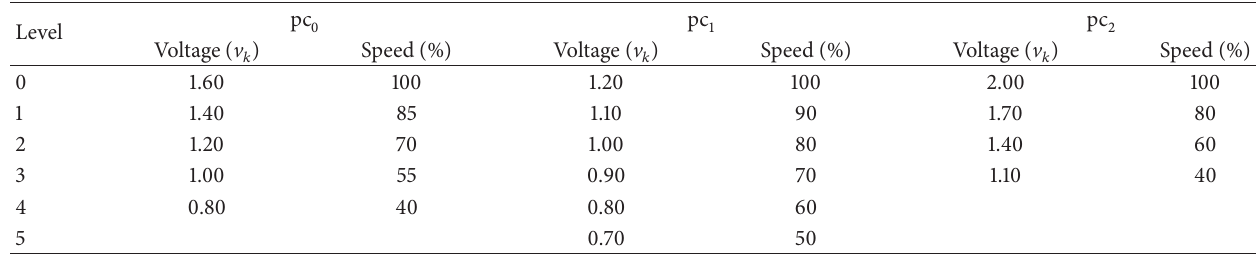
(c) Result of PCS of EECS Figure 2: Schedules of 𝐺 with EECS and ECS algorithms. Table 1: Voltage relative speed pairs.